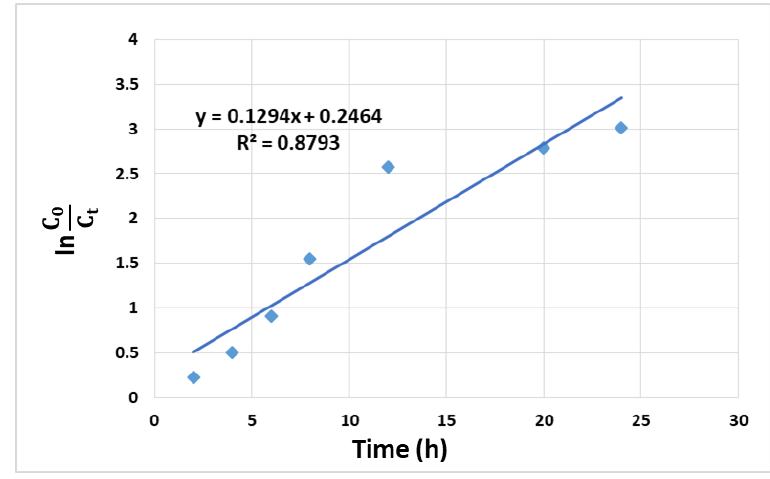
Figure 12. Model of the first-order apparent kinetics.